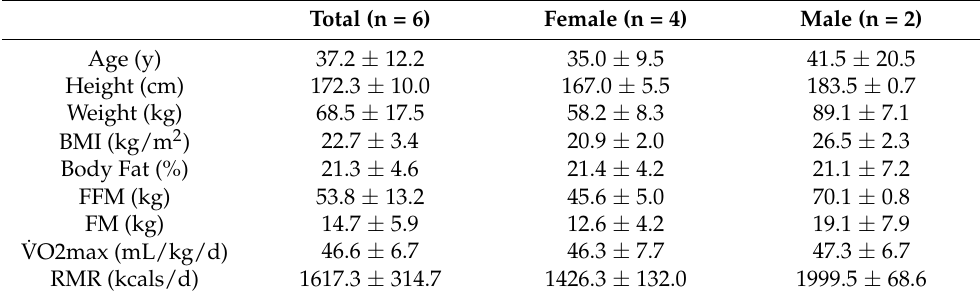
Table 1. Participant